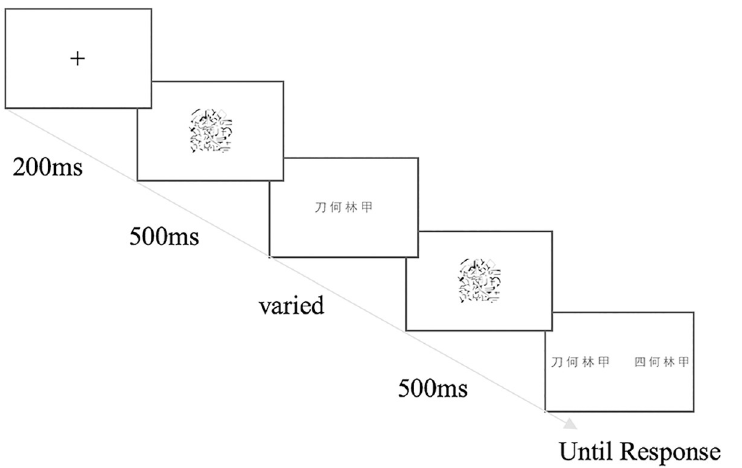
Fig 1. A sample trial of the perceptual fluency task for